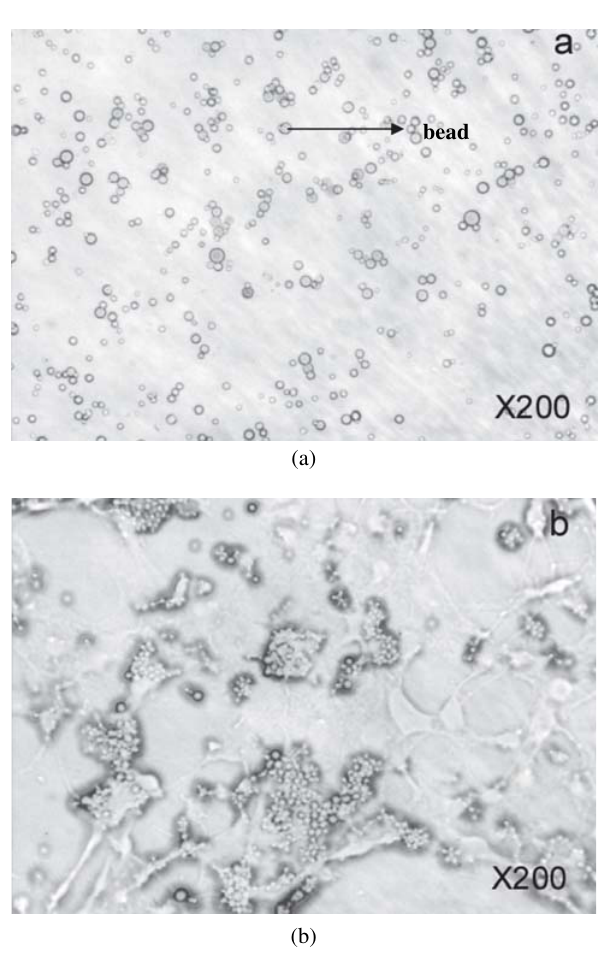
Figure 3. HPMA copolymer beads control (a, 200 ×) and their interaction with the COS-7 cells (b) seeded in regular medium and incubated at 37 °C for 72 h (200 ×). Note the cell attachment to the beads and cell growth in the background.